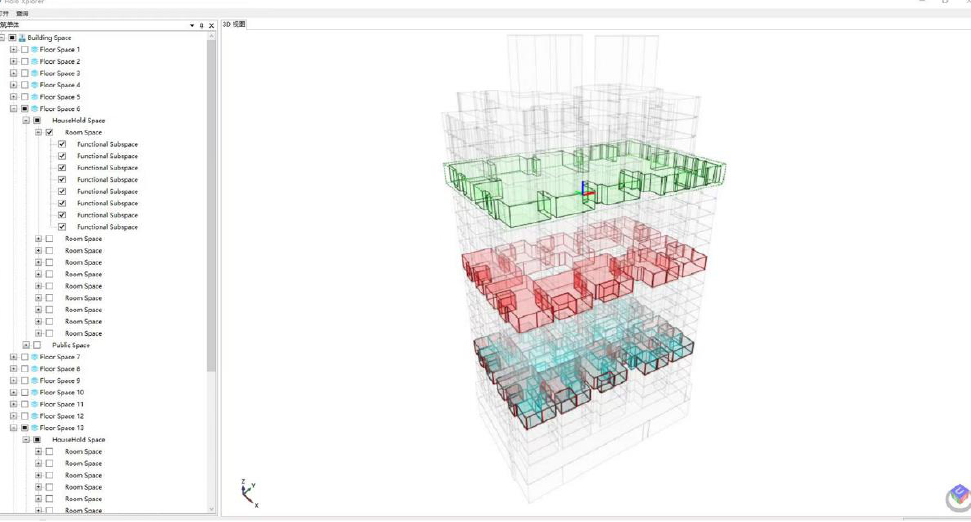
Figure 17. Indoor space classification system.